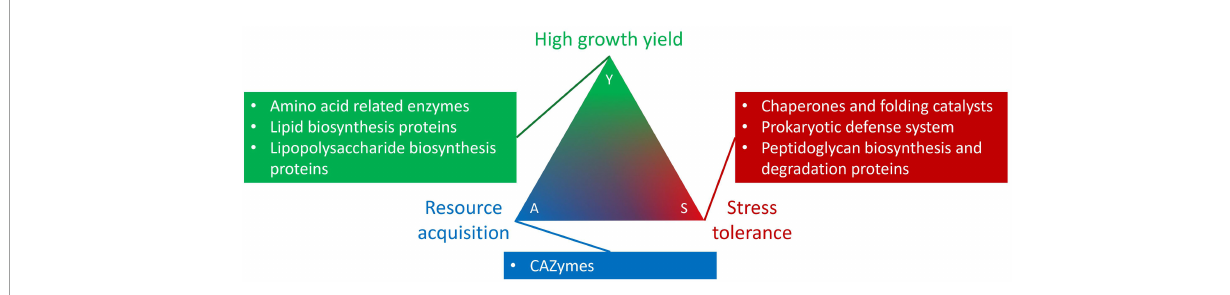
FIGURE1 Genome-based trait groupings into the Y-A-S life history strategy framework developed by Malik et al. (2020).